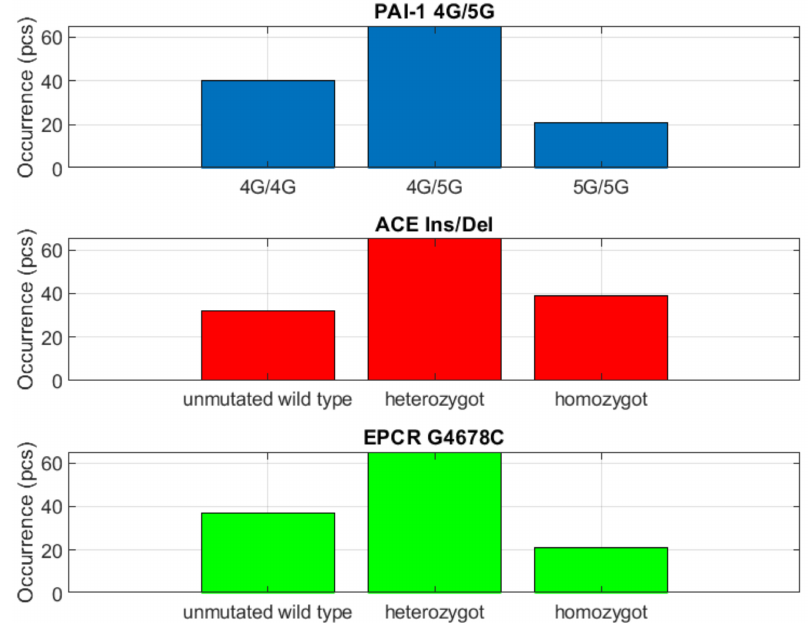
Figure 7. Dominating